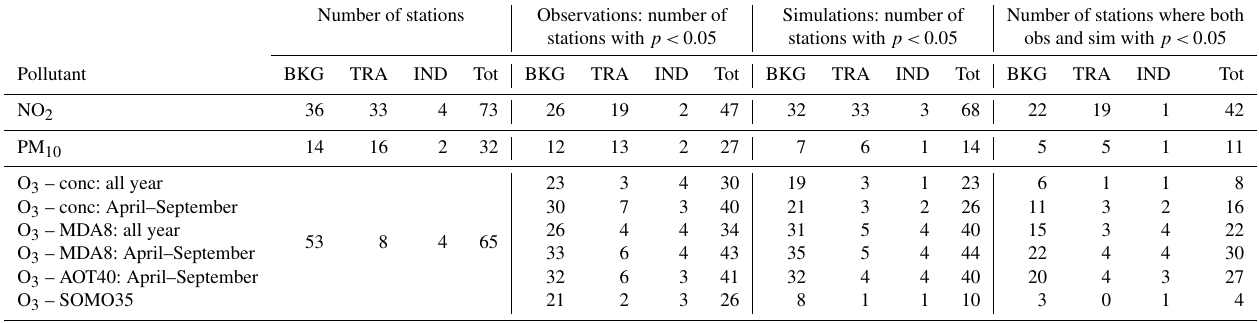
Table 2. Number of stations considered in the trend analysis for the period 2003–2010 separated into background (BKG), traffic (TRA), and industrial (IND) and classified as statistically significant ( p < 0.05) for observed, simulated, and both observed and simulated trends.